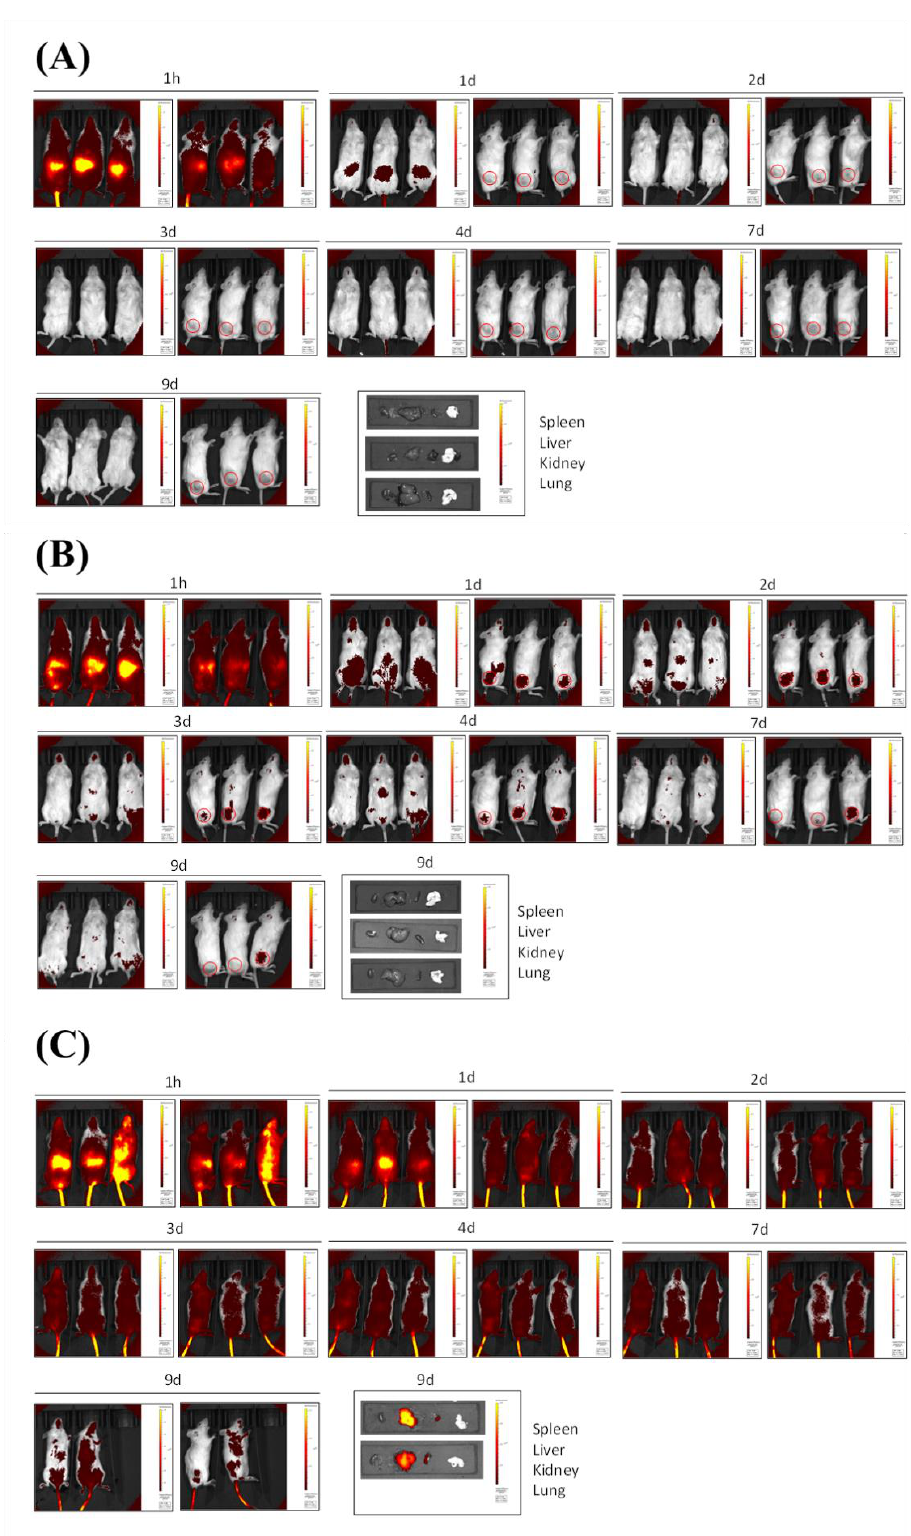
Figure 4. In vivo fluorescence imaging biodistribution in subcutaneous tumor mice models. Nine- days biodistribution pattern of ( A ) A375 challenged NSG mice treated with a 40 µM solution of ICG ( n = 3/group), ( B ) A375 challenged NSG mice treated with amphoteric ICG-NCs ( n = 3/group) at 40 µM ICG, and ( C ) A375 challenged NSG mice treated with cationic ICG-NCs ( n = 3/group) at 40 µM ICG. Locations for tumor cells injections have been indicated with a red circle.